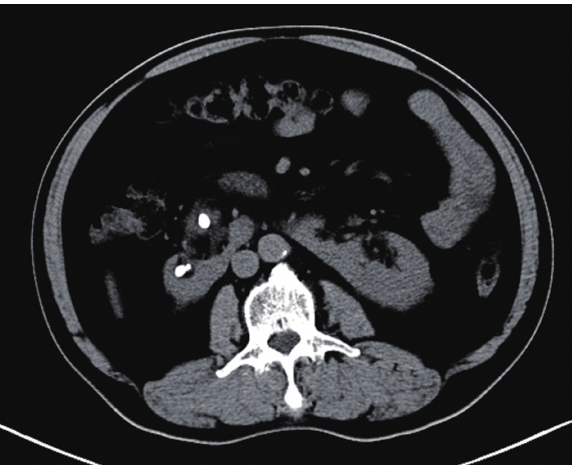
Table 1 - Demographic characteristics and surgical statistics. Figure 1 - CT scan of renal stones in a horseshoe